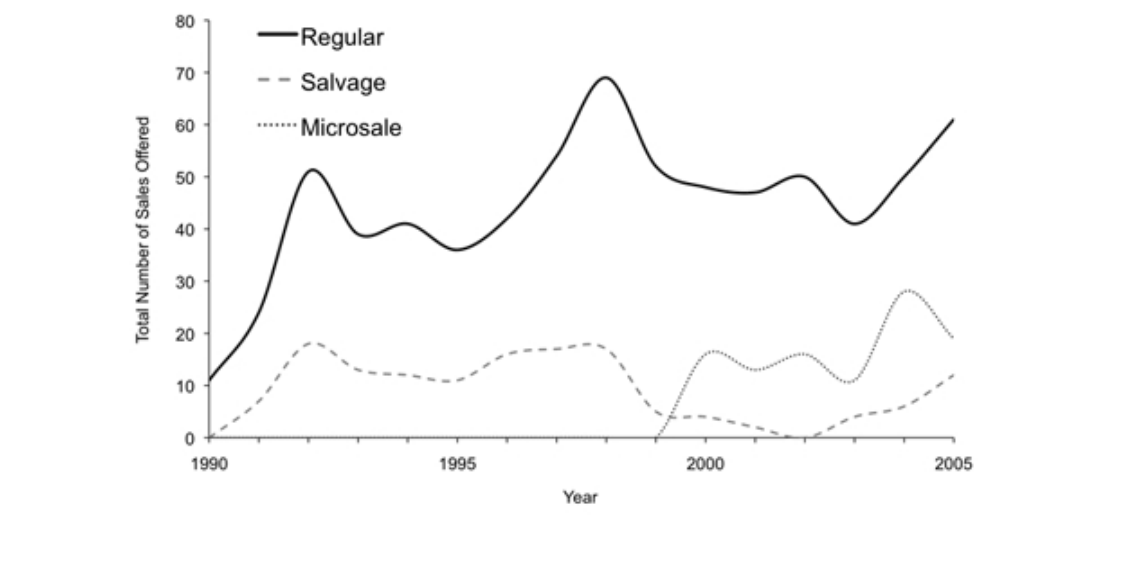
Fig. 8 . Total number of timber sales offered by type (regular, salvage, microsale) in the Tongass National Forest, from 1990-2005; note that the microsale program began in